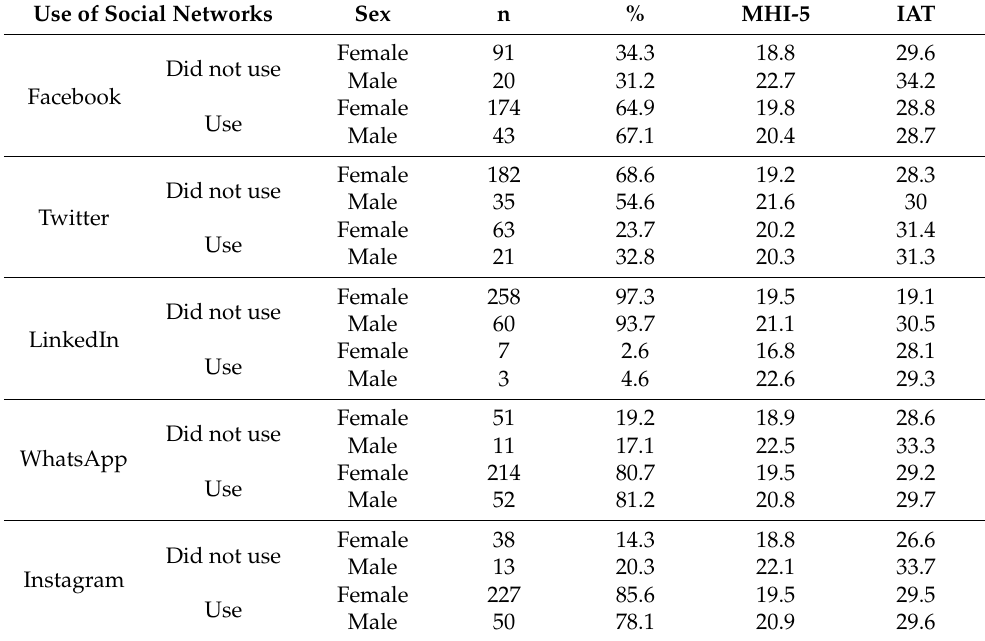
Table 4. Type of social media during confinement COVID-19 and Mental Health, Internet Addiction and